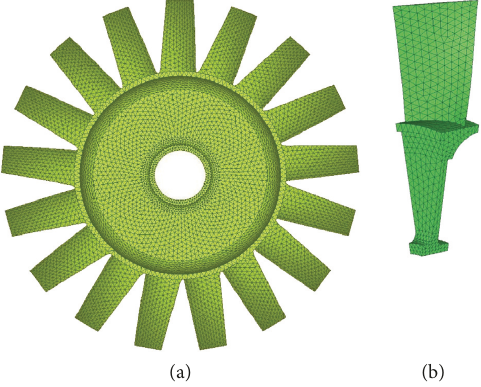
Figure 1: Finite element model of a bladed disk and its sector model.